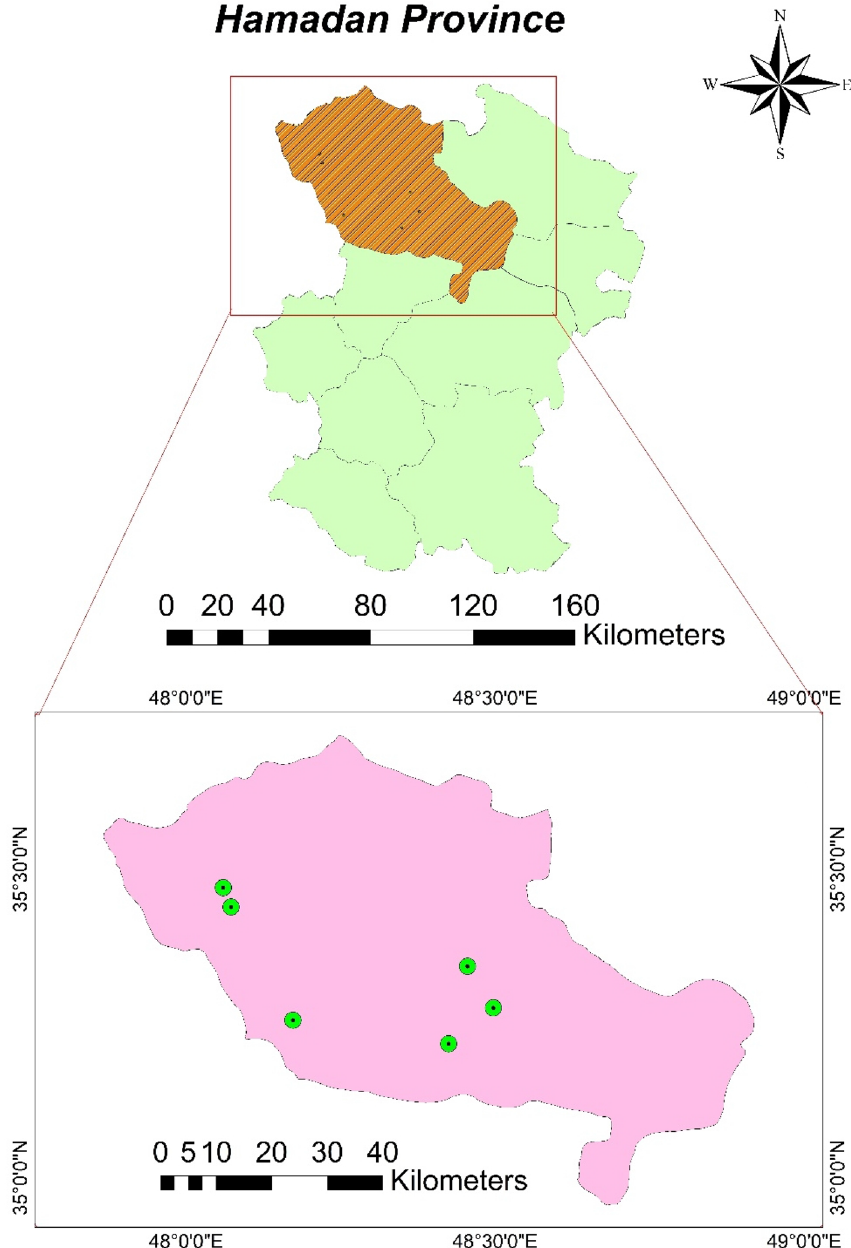
Figure 1. Location of the study area and selected village for fingernails sampling (ArcGIS version